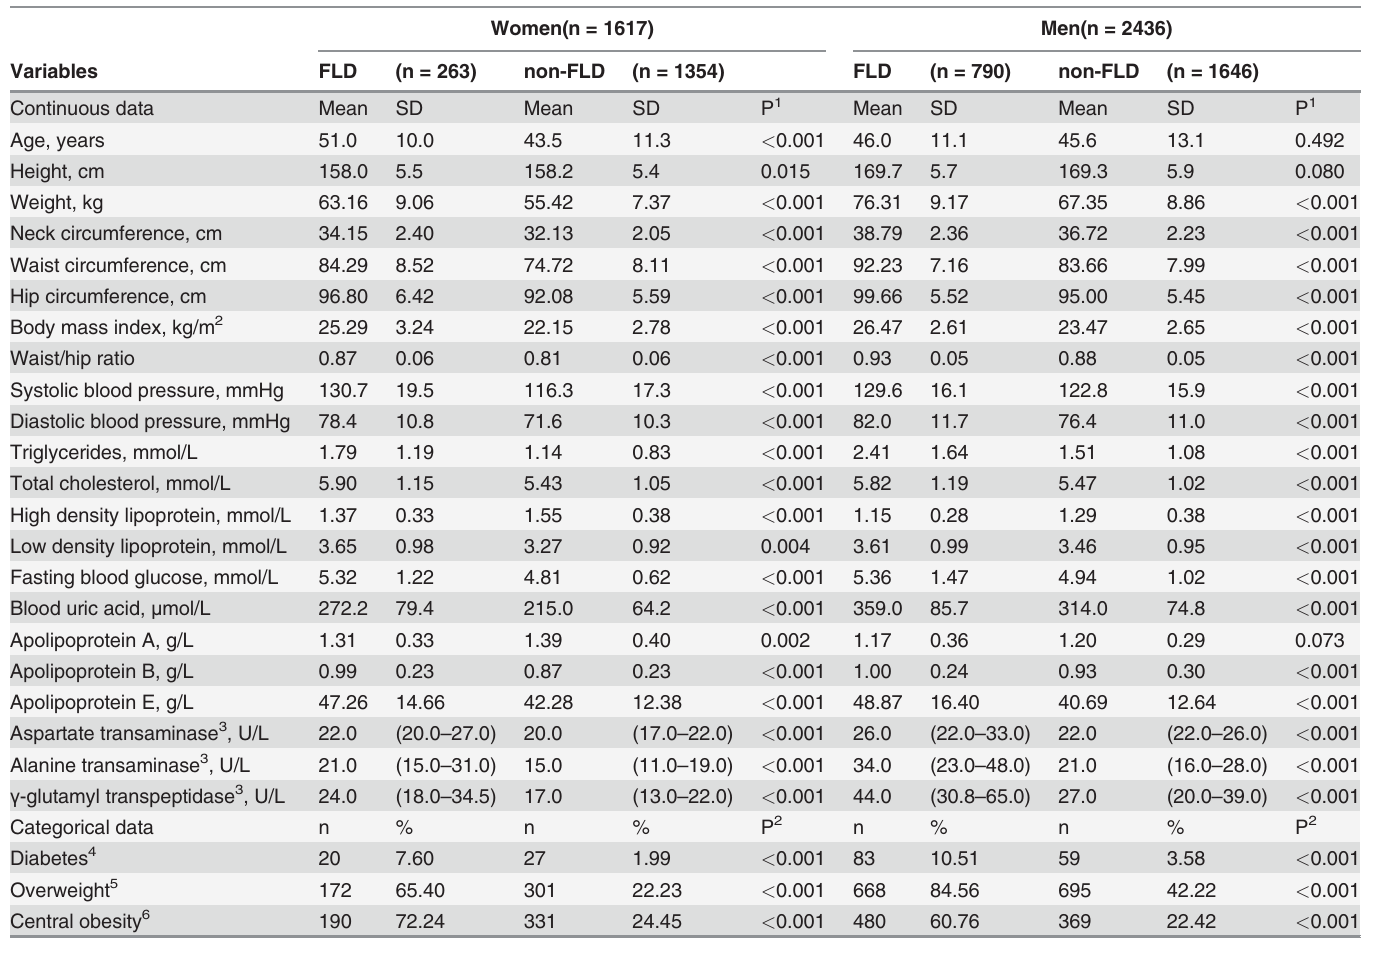
Table 1. Characteristics of subjects with (FLD) and without (non-FLD) FLD (age-adjusted) (n =